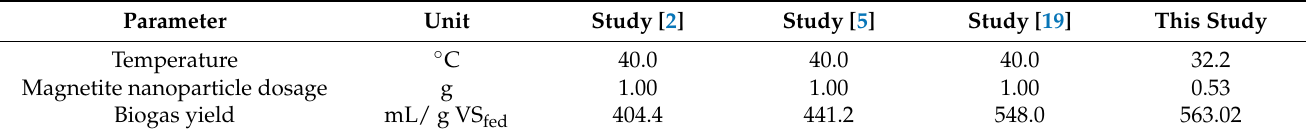
Table 9. Comparison of previous studies and this study.